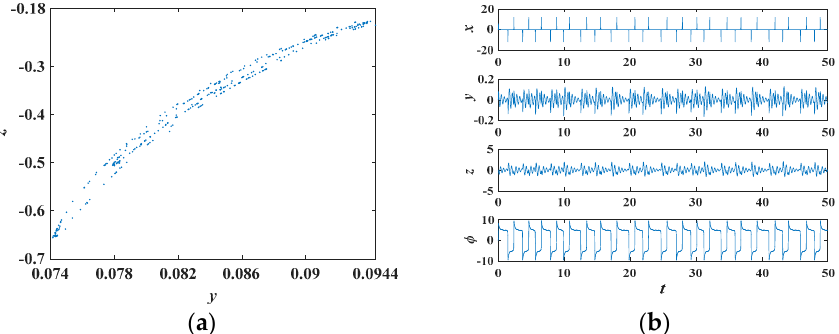
Figure 7. ( a ) Poincaré mapping on the ( y , z ) plane; ( b ) the time domain waves of the states x , y , z , and φ .